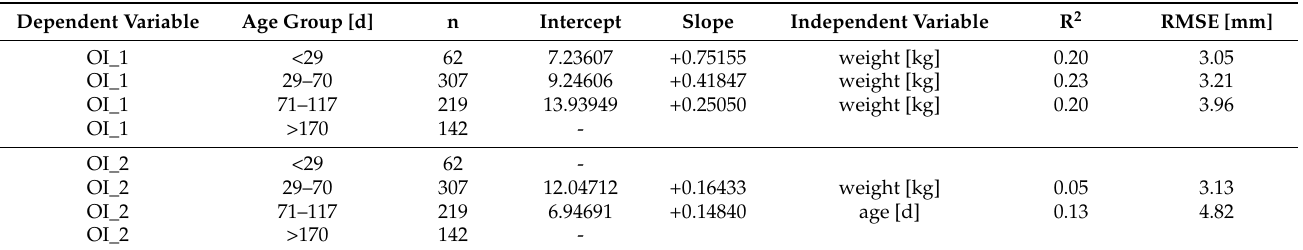
Table 5. Results of the stepwise regression analysis divided into the four age groups and separated to measurement points 1 and